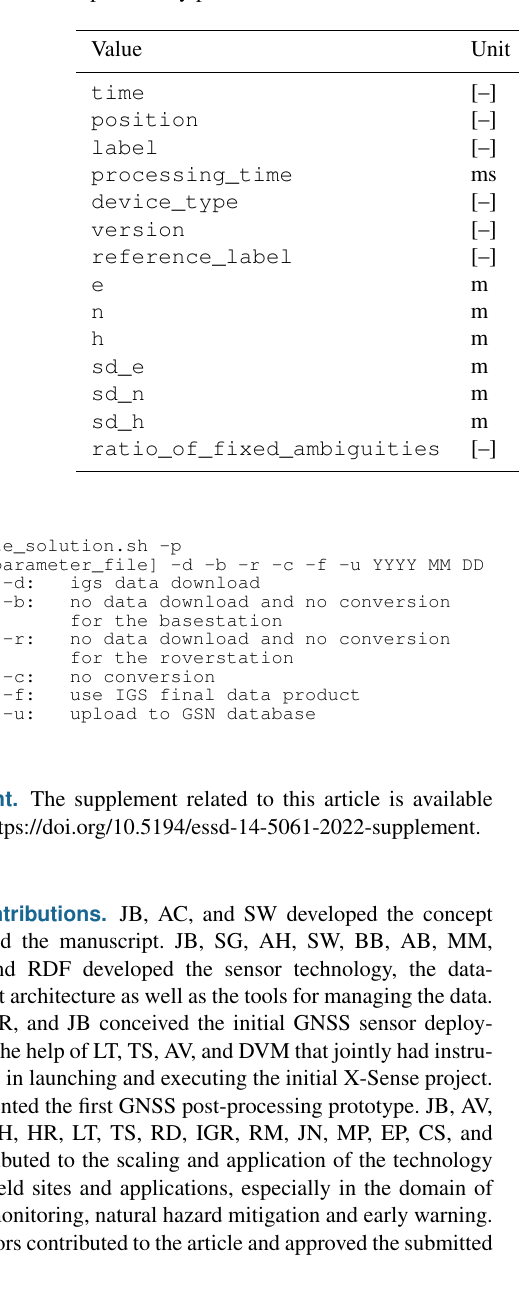
Table D1. GNSS computed daily position data CSV file